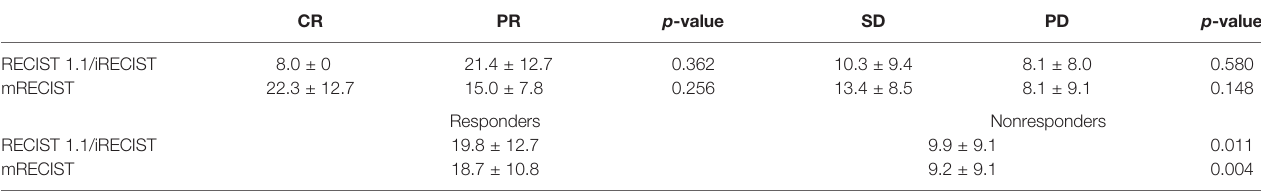
TABLE 6 | Compares PFS (months) between patients with CR and PR and patients with SD and PD and between responders and nonresponders according to different response assessment methods. CR PR p -value SD PD p -value